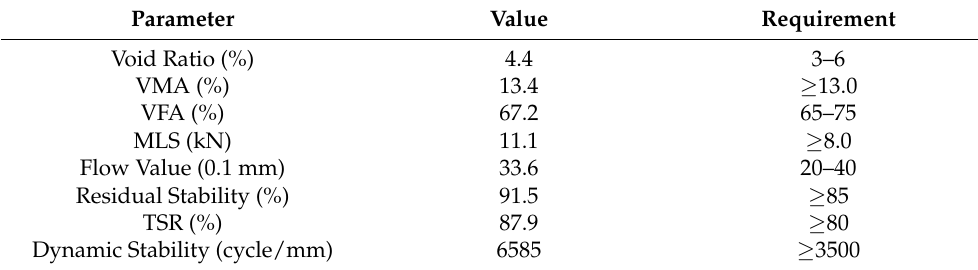
Table 6. Summary of the volumetric and mechanical parameters of the AC-20 asphalt mixture.